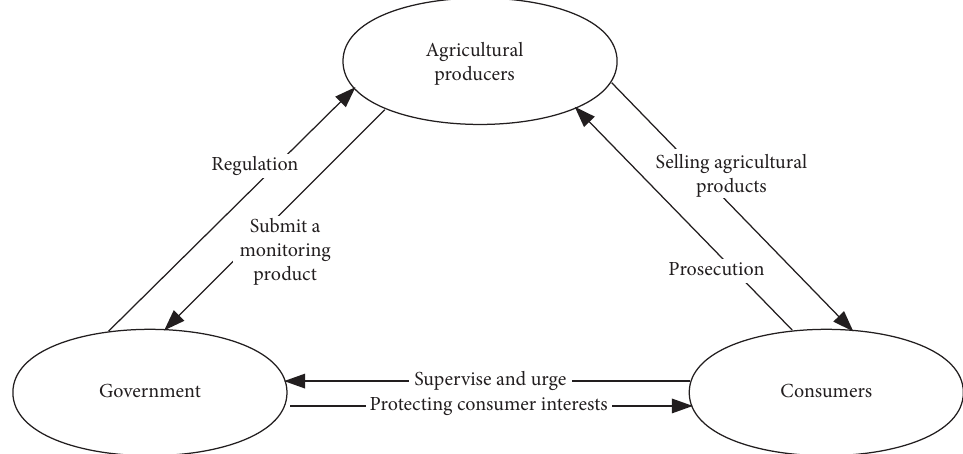
Figure 3: Agricultural products standardized production body relationship